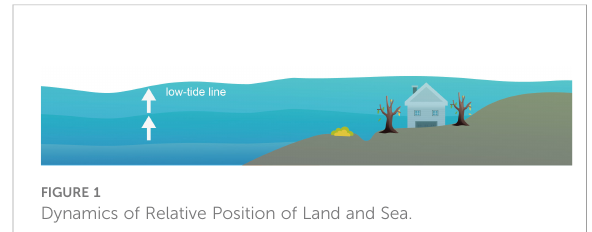
FIGURE 1 Dynamics of Relative Position of Land and